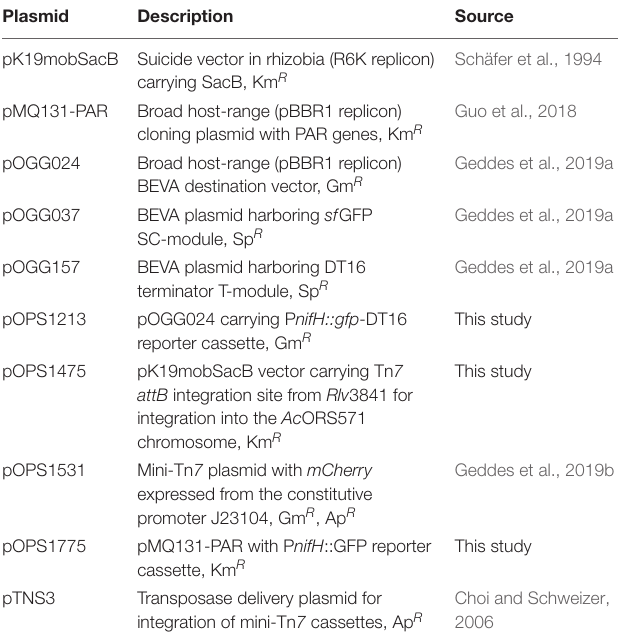
TABLE 2 | Plasmids used in this